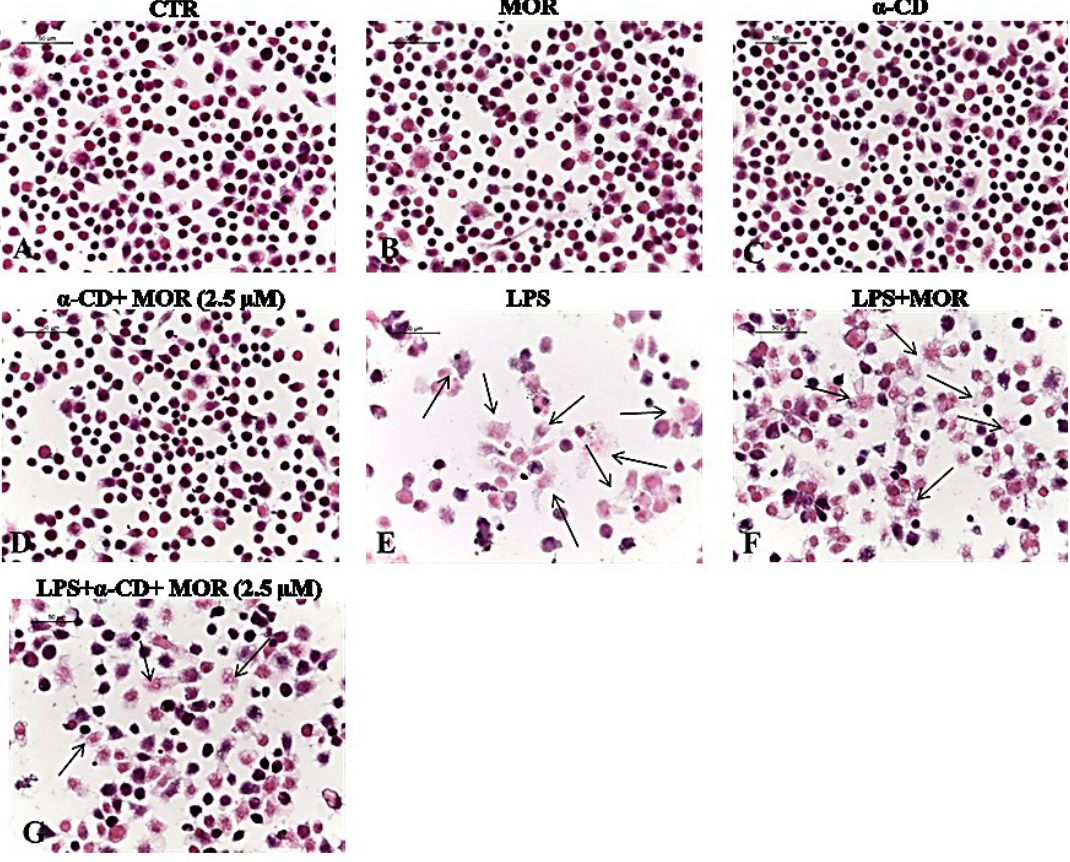
Figure 2. Cytoprotective effect of α -CD/MOR in LPS-stimulated RAW macrophages. Eosin and haematoxylin stain (E&H) staining displayed no morphological changes or cell loss in untreated control ( A ); MOR alone ( B ); α -CD alone ( C ) and α -CD/MOR (2.5 µ M) ( D ) treated macrophages. Increased cell size (black arrows) and cell death was observed in LPS-stimulated macrophages ( E ). LPS-stimulated elongated macrophages were less with relative increase in cell numbers in one week old α -CD+MOR-pretreated macrophages ( G ) than that of macrophages pretreated with one week old MOR alone ( F ). All images were taken at 40 × (bar 50 µm).